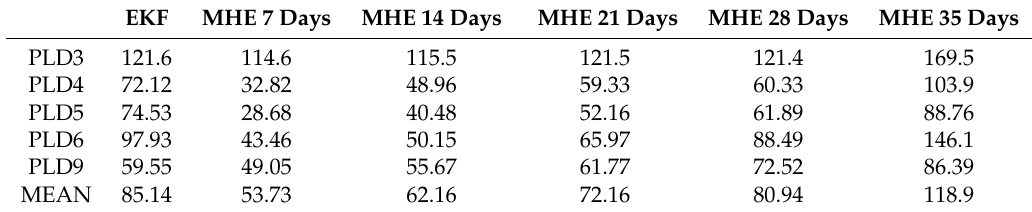
Table 3. RMSE between the measured and estimated